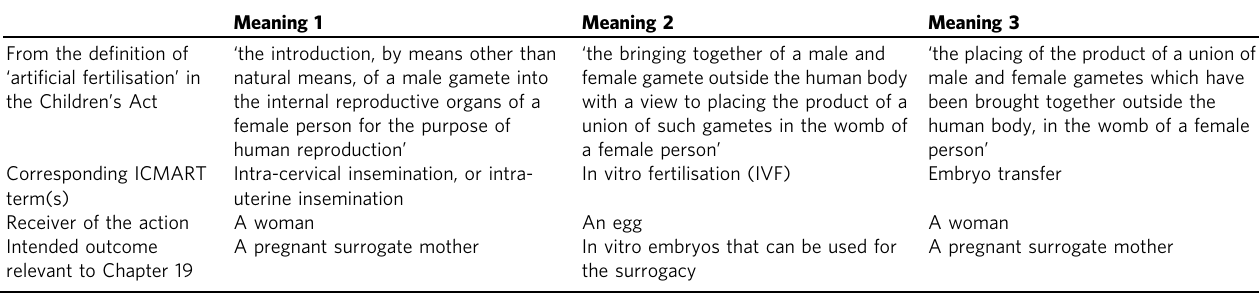
Table 1 Meanings of ‘ arti fi cial fertilisation ’ in the Children ’ s